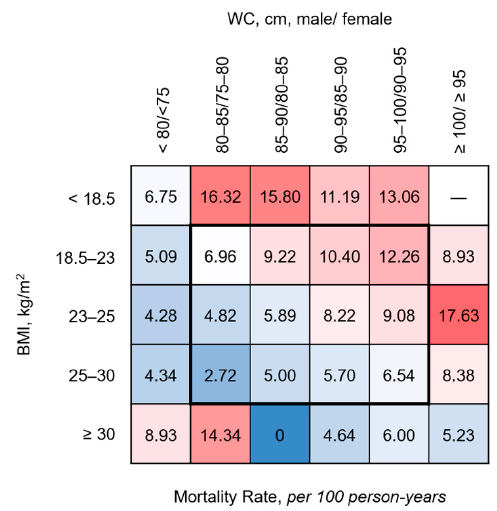
Figure 4. Mortality rates according to the 5 baseline BMI categories and 6 baseline WC categories. Each square indicates the morality rate calculated per 100 person-years for the variable indicated by the row and column. Red and blue colors indicate higher and lower mortality rates, respectively. BMI, body mass index; WC, waist circumference.